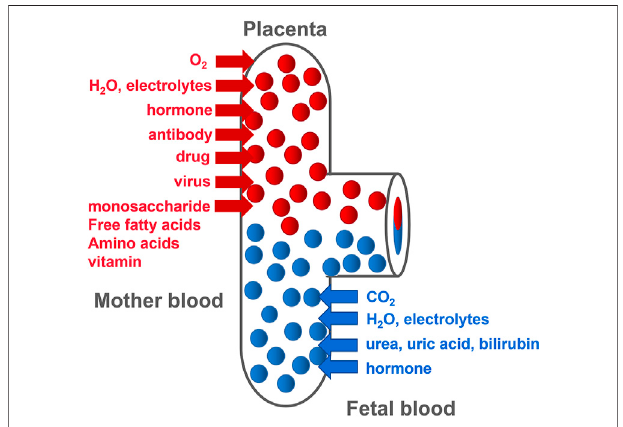
FIGURE 1 | Diagram of material exchange between mother and